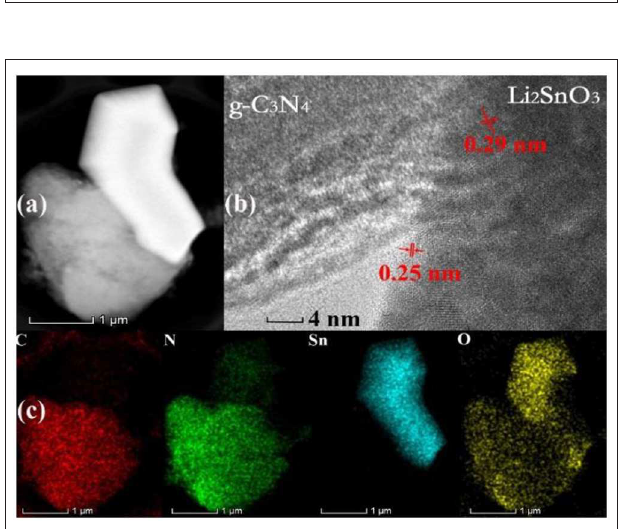
FIGURE 3 | Heterojunction LSO-CN-85: (a) HAADF-TEM, (b) HRTEM, and (c) elemental